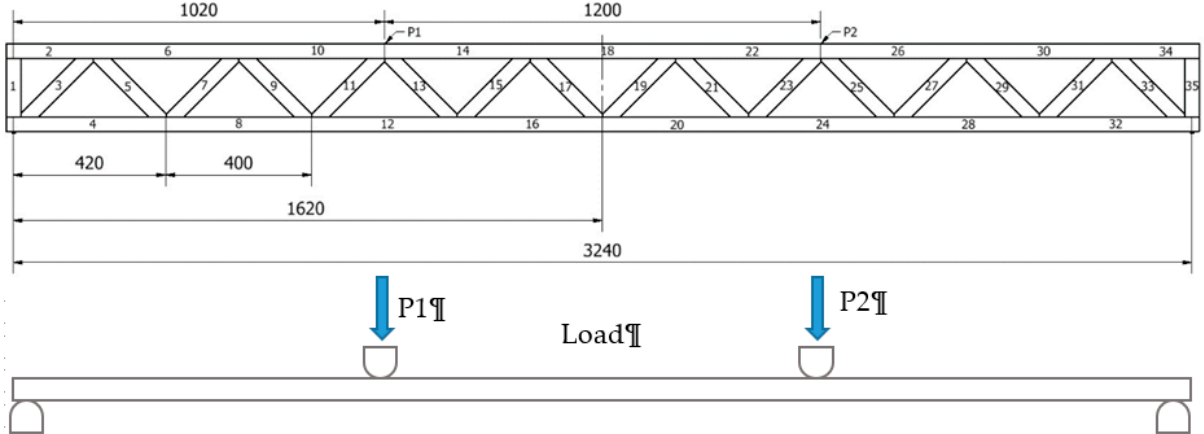
Figure 3. Truss loading diagram at two distinguished nodes (P 1 = P 2 = 11.12 kN )—scheme